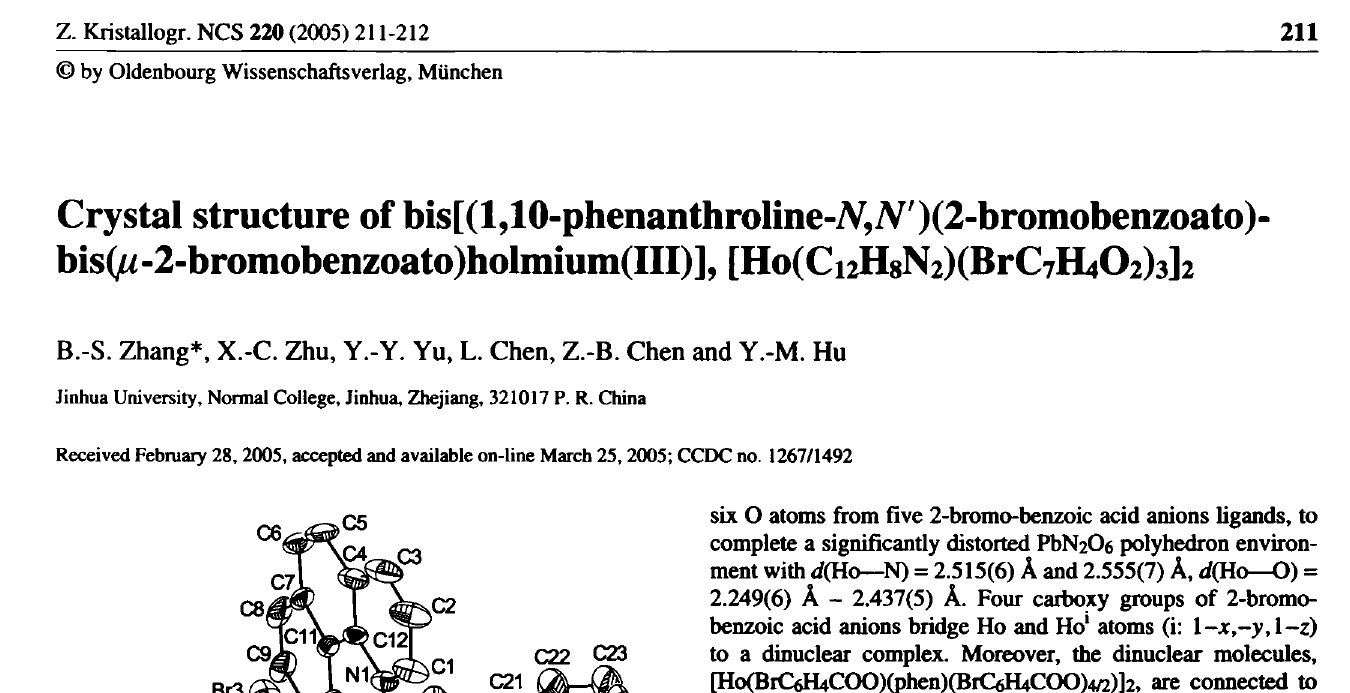
Table 1. Data collection and handling.